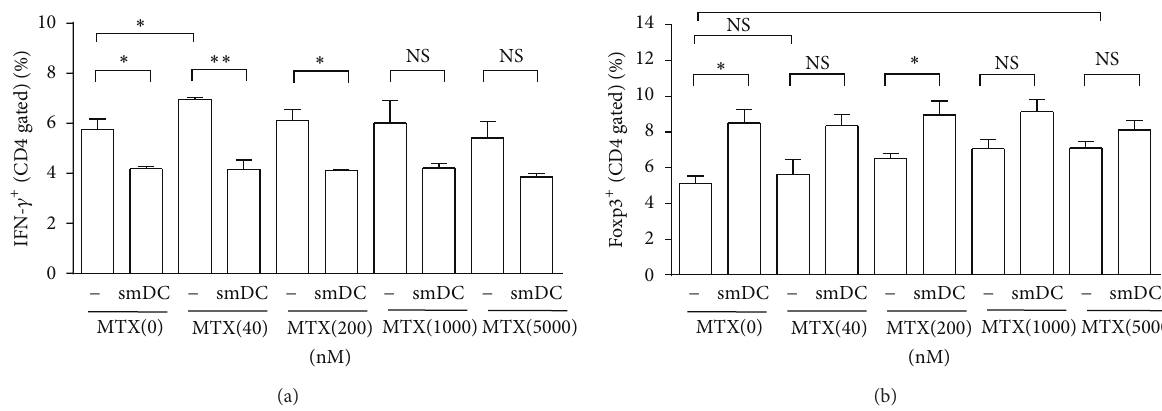
Figure 6: SmDC inhibited Th1 response and induced Treg response regardless of MTXin coculture with arthritogenic T cells. Arthritogenic T cells, collected from CIA mice 21 days after CII-inoculation, were cocultured with smDC in the presence or absence of MTX up to 5000 nM. (a) CD4 + IFN- 𝛾 + Th1 cells were analyzed by FACS. (b) CD4 + Foxp3 + Treg cells were analyzed by FACS. Statistical data are shown from 3 different mice as mean ± SEM. ∗ 𝑝 < 0.05 , ∗∗ 𝑝 < 0.001 in Student’s 𝑡